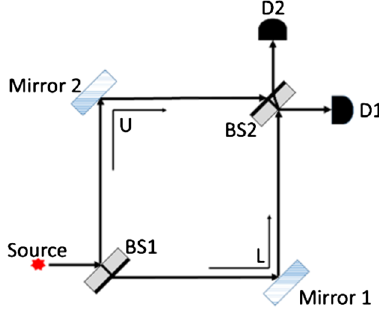
FIG. 5. MZI setup with a vertical polarizer placed in the upper path.